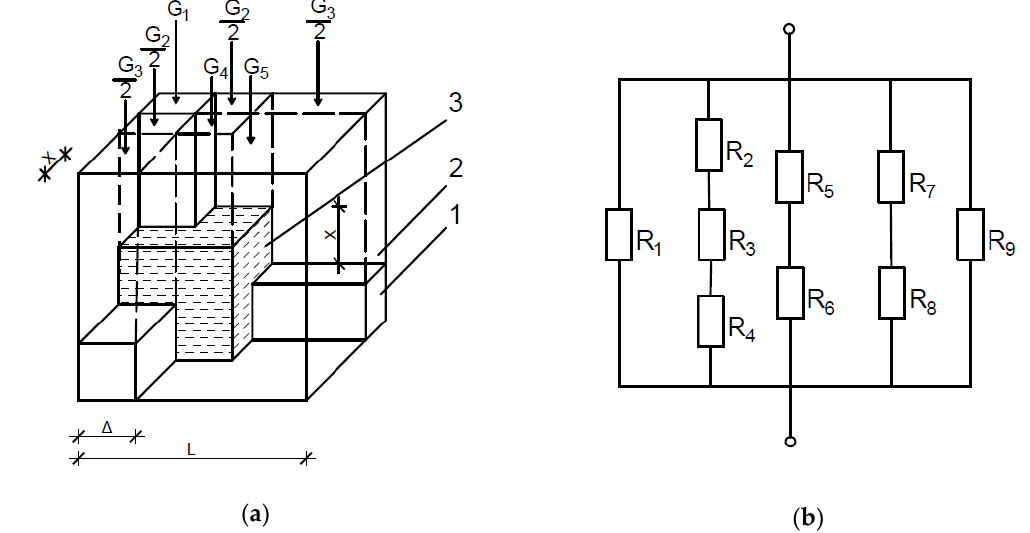
Figure 4. The eighth part of the unit cell with isolated liquid inclusion and G 1 ... G 5 of the total heat flux G ( a ) and a diagram of the connection of thermal resistances of the elements ( b ); 1, 2, 3—solid, gas and liquid component of the structure, respectively.